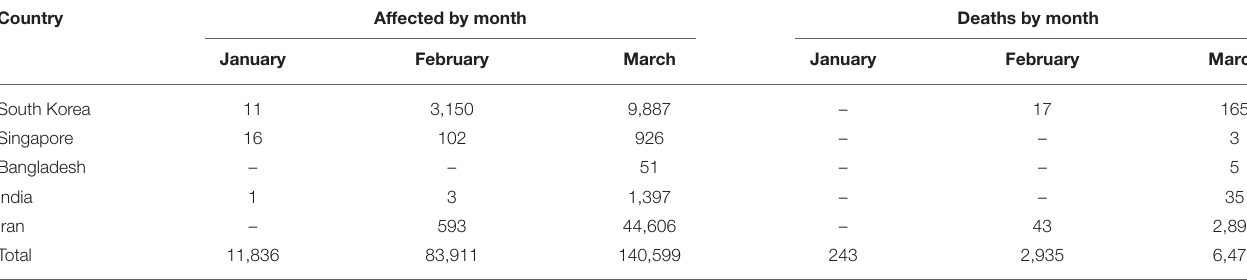
TABLE 2 | Compilation of data of the number of people affected by COVID-19 in selected Asian countries. Country Affected by